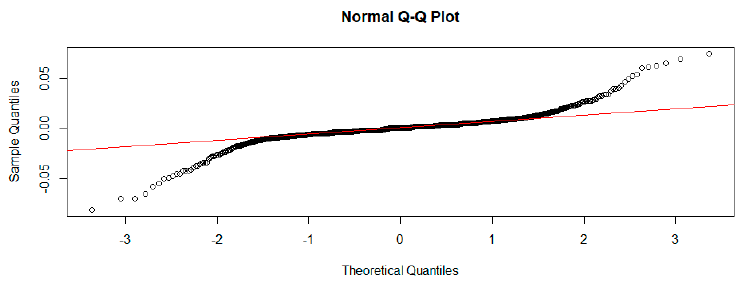
Figure 4. Quantile − quantile plot of selected data.